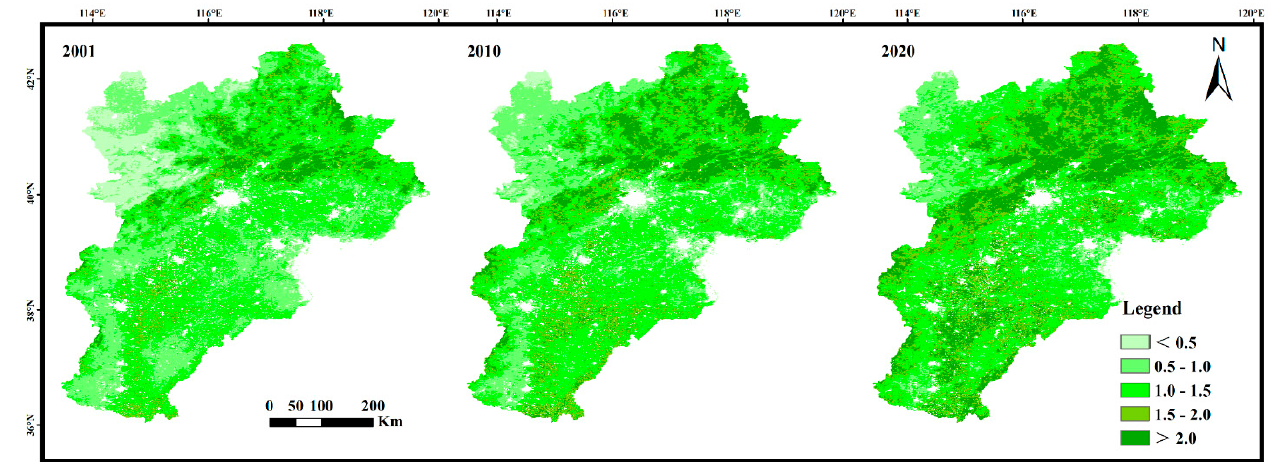
Figure 6. Spatial distribution of the average growing season LAI value in 2001, 2010, and 2020.